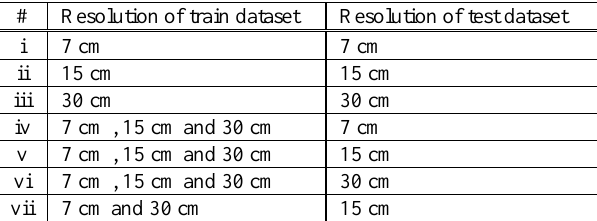
Figure 10. Comparison of detection rate between combinations of multiple spatial resolutions (i, iii, iv and vi) Table 9. Experiment patterns of multi spatial resolution